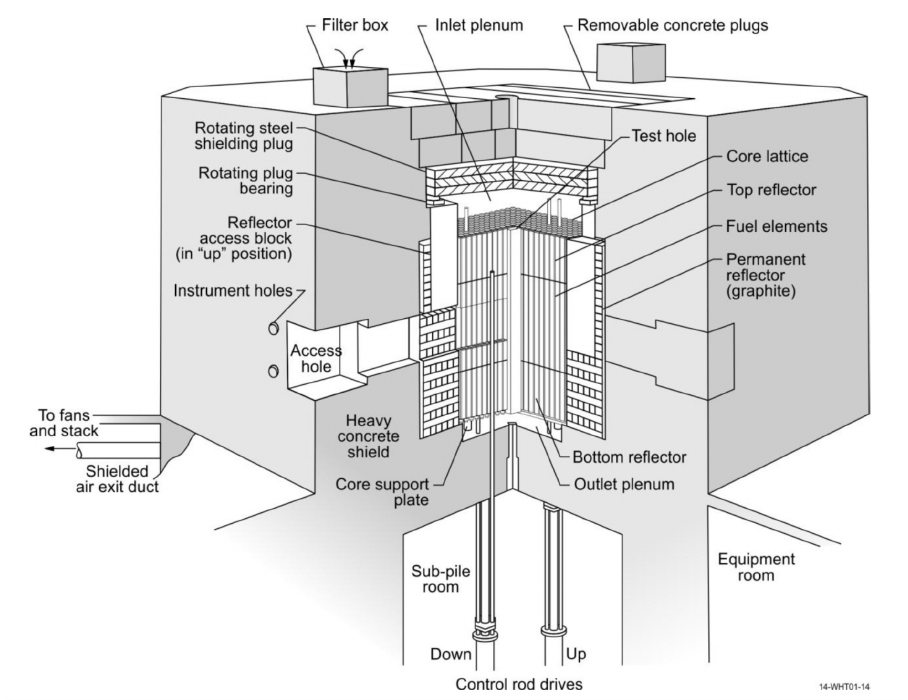
Figure 2. Cutaway illustration of the TREAT core, reflectors and biological shielding, showing the numerous penetrations into the core interior